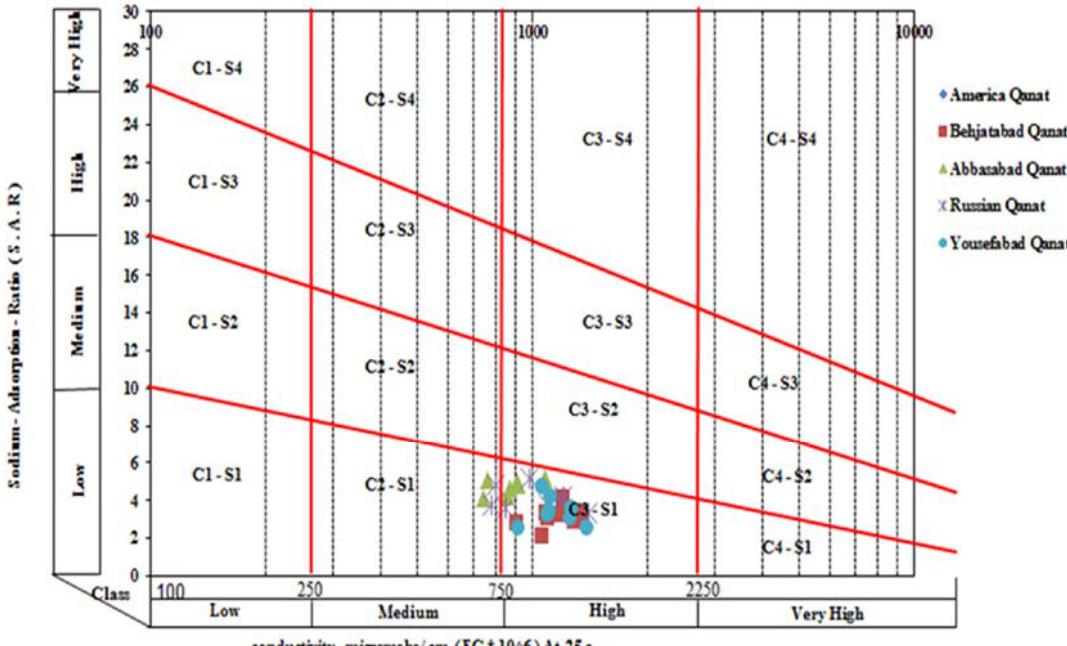
Fig. 18: Wilcox diagram of the studied aqueducts (Qanats)